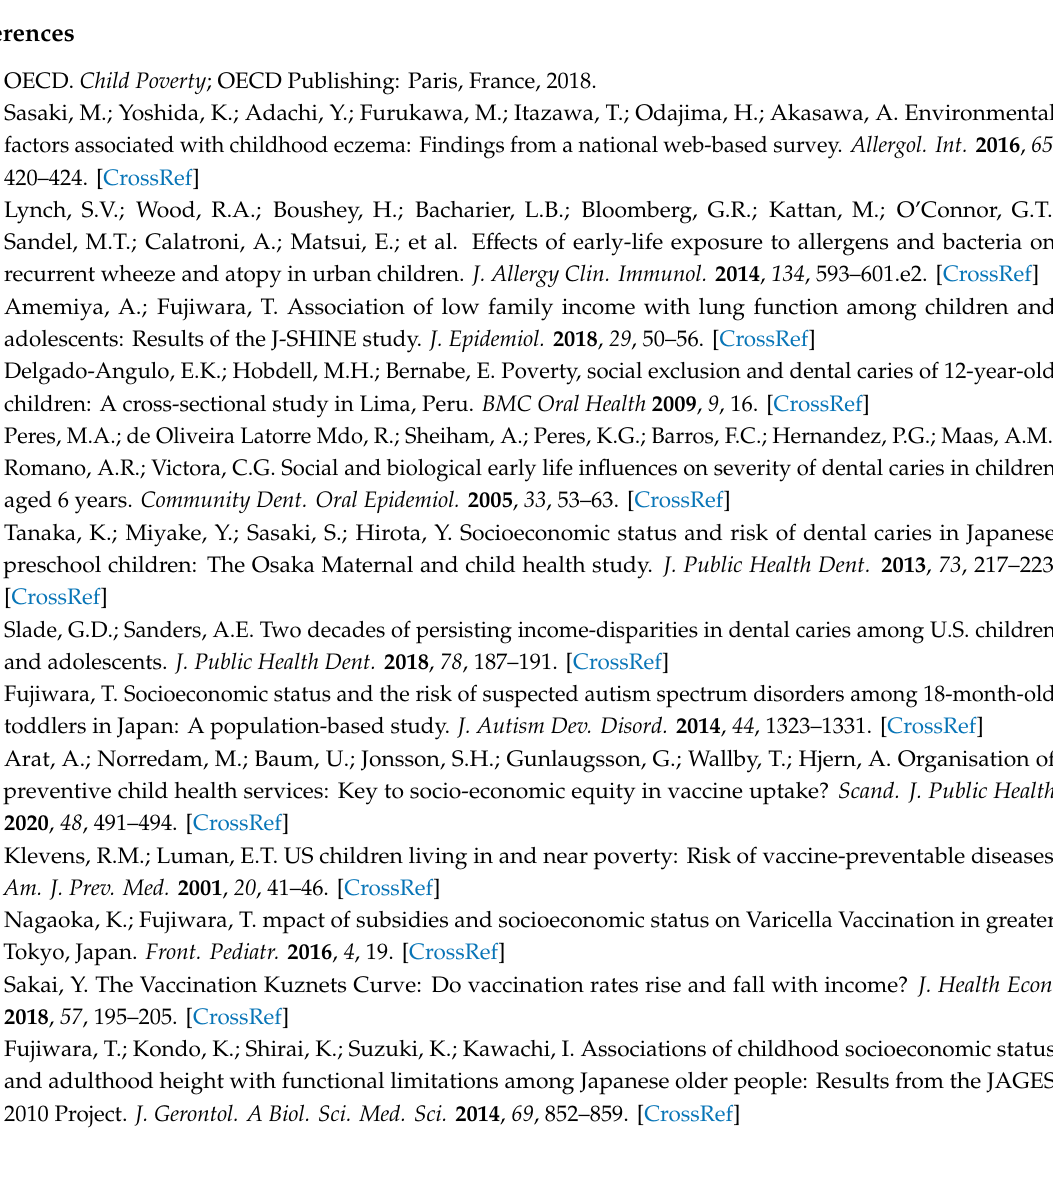
Table S1: The associations of parental involvement behaviors, parental interaction with child, and parental care for child’s physical health with self-esteem among adolescents living in poverty ( n = 3696). Table S2. The association between total number of parental involvement behaviors and self-esteem among adolescents not living in poverty ( n = 7088). Table S3. The associations of poverty and parental involvement behaviors with self-esteem in total sample ( n = 10,784). Table S4. Association between parental involvement behaviors and young adolescent’s self-esteem among adolescents living in poverty ( n = 3696). Table S5. Association between parental involvement behaviors and young adolescent’s self-esteem among adolescents living in poverty ( n =